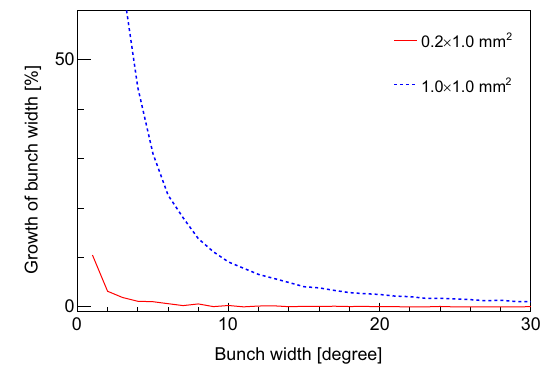
FIG. 18. Estimated growth of the bunch width with the HOPG- BSM using different sizes of HOPG targets in the